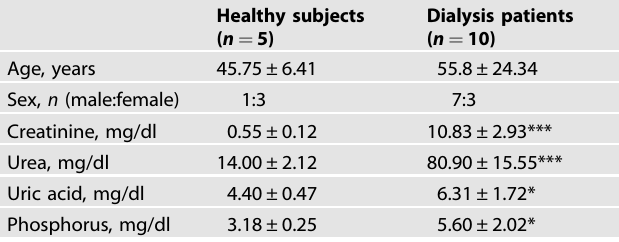
Fig. 4 Bath application of dialysis serum mimics the effects of Guanidine on glutamatergic transmission. A , B Glutamatergic basal activity (fEPSP slope % of basal control) was increased following the in vitro application of dialysis serum (10 and 50 µM) for 10 min. A Two-way ANOVA: Healthy 10 µM, n = 4, F (4, 24) = 1.05, pre vs post 1 – 10 min, Bonferroni ’ s post hoc test p > 0.05; Dialysis 10 µM; n = 5, F (4, 32) = 0.46, pre vs post 2 – 4, 6 – 8, and 10 min, Bonferroni ’ s post hoc test * p < 0.05, ** p < 0.01, and *** p < 0.001. Two-way ANOVA time × group interaction: Healthy 10 µM vs Dialysis 10 µM, F (10,70) = 7.24, Bonferroni ’ s post hoc test ### p < 0.001. B Two-way ANOVA: Healthy 50 µM, n = 7, F (4, 48) = 0.11, pre vs post 1 – 10 min, Bonferroni ’ s post hoc test p > 0.05; Dialysis 50 µM, n = 5, F (4, 32) = 0.45, pre vs post 2, 4, 6, and 8 – 10 min, Bonferroni ’ s post hoc test * p < 0.05, ** p < 0.01, *** p < 0.001 and two-way ANOVA time × group interaction: Healthy 50 µM vs Dialysis 50 µM, F (10,100) = 9.16, Bonferroni ’ s post hoc test ### p < 0.001). Table 1. Demographic and clinical features of healthy subjects and dialysis patients (mean ±